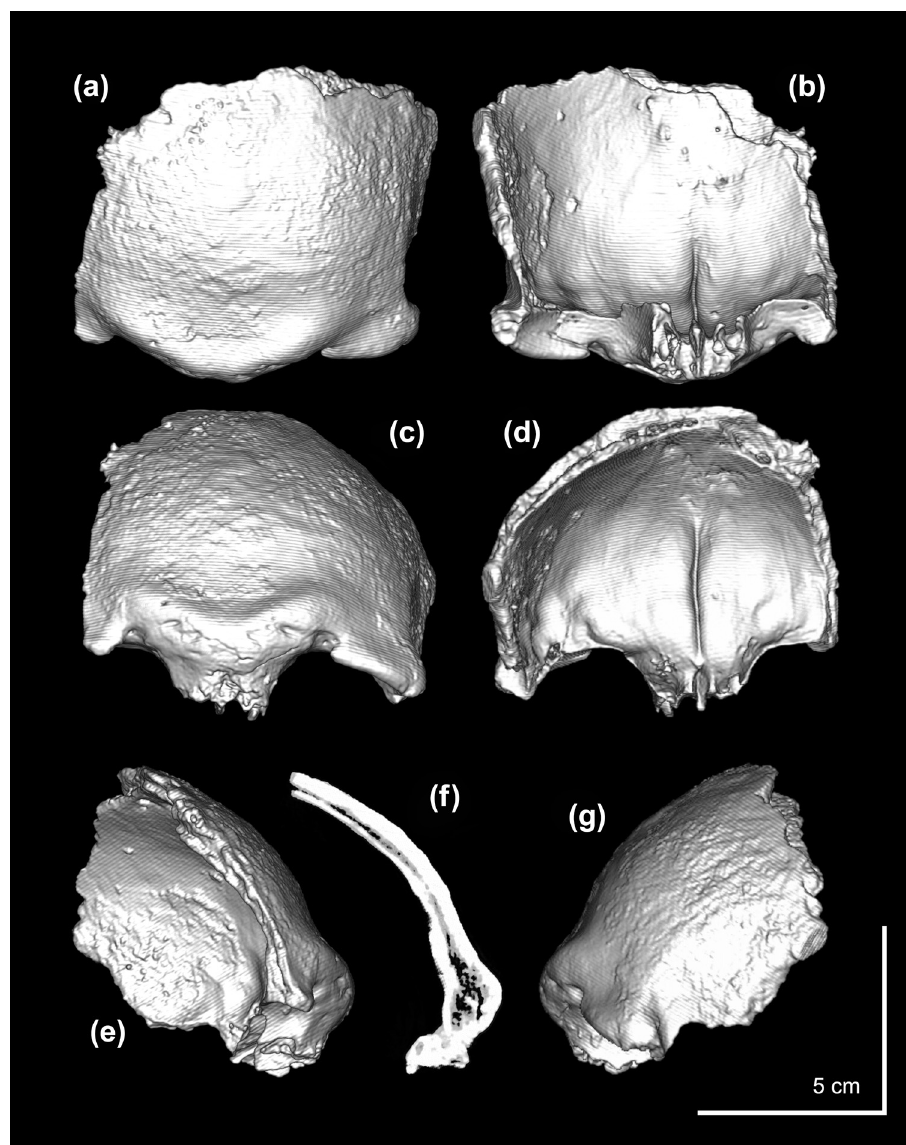
Figure 5: CT scan ectocranial views of frontal bone 7001 ( by OsiriX DICOM Wiever ) : ( a ) norma verticalis , ( b ) superior part ( endocranial ) , ( c ) norma frontalis , ( d ) posterior ( endocranial ) , ( e ) right norma lateralis , ( f ) sagittal section, and ( g ) left norma